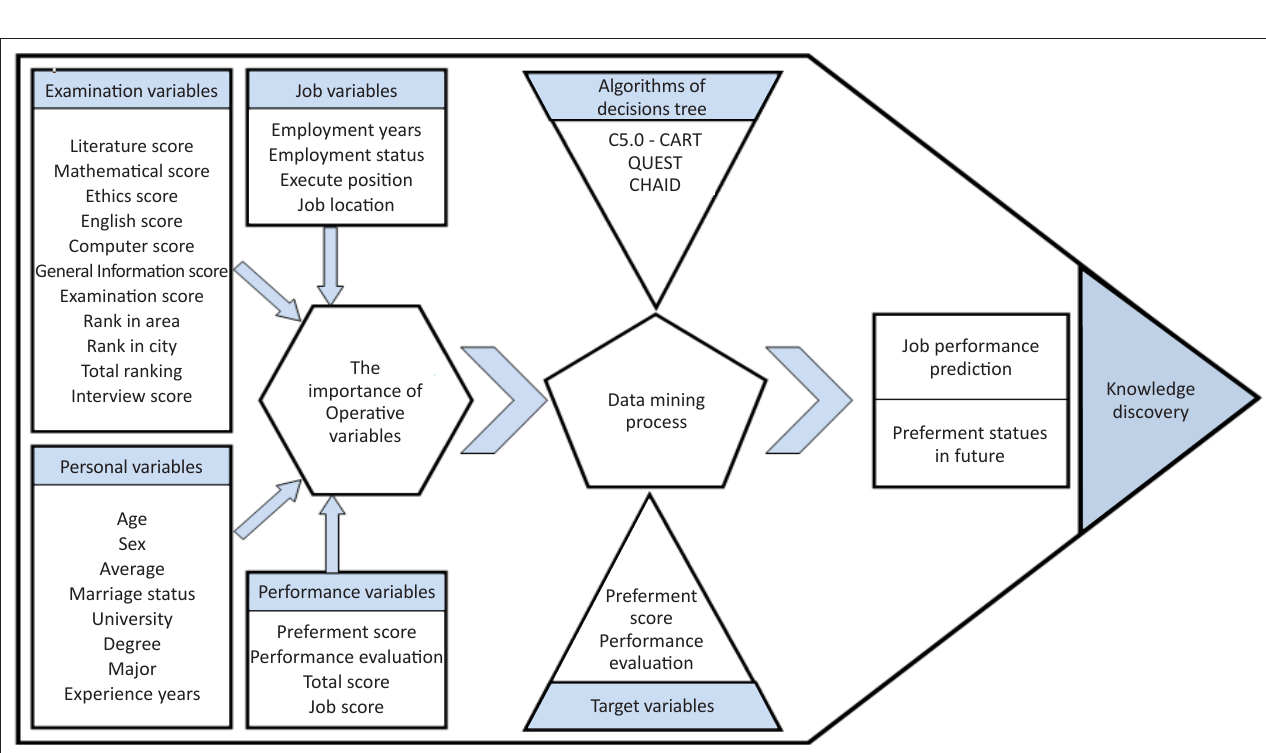
FIGURE 1: Knowledge discovery conceptual model from database of entrance examinations.